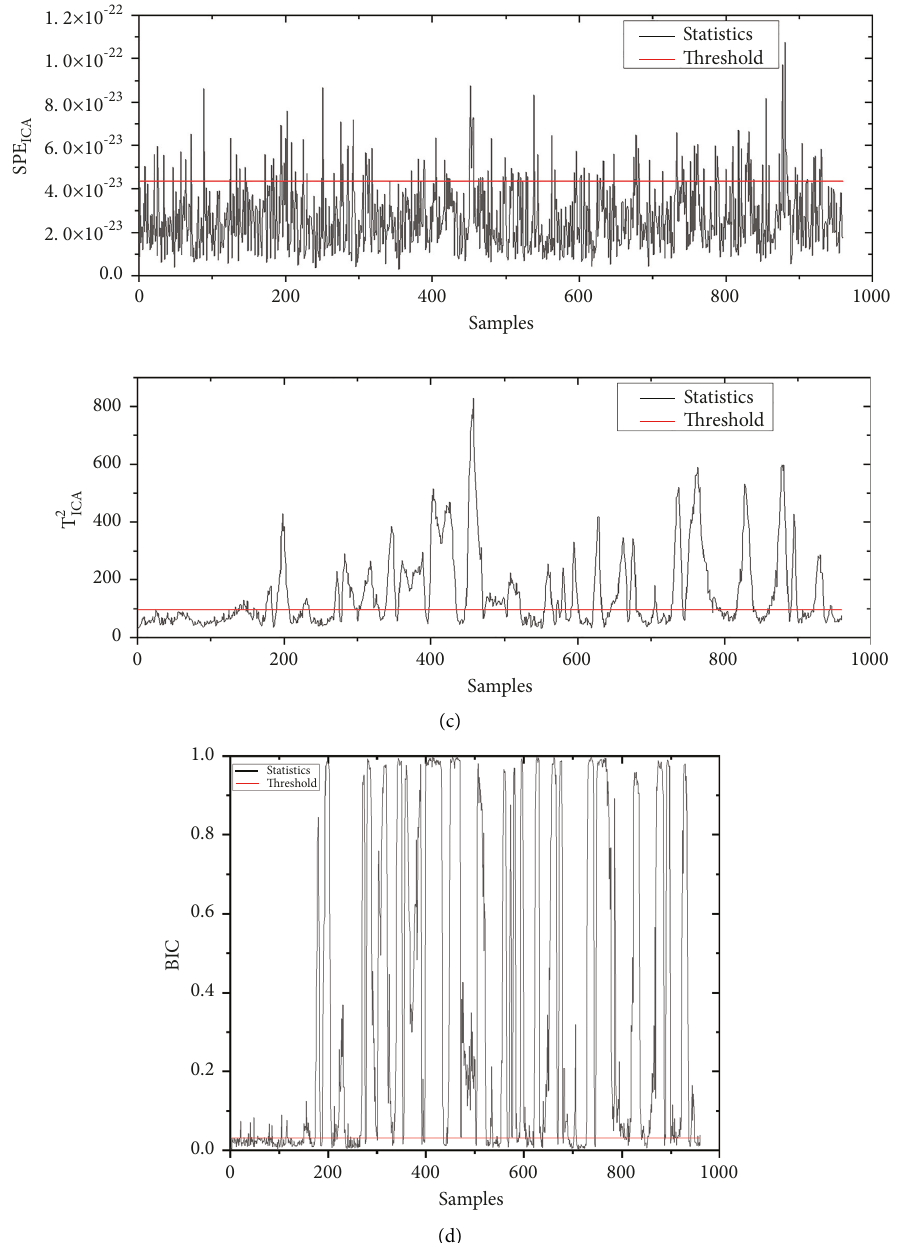
Figure 4: Monitoring results of fault 16 in the TE process: (a) PCA; (b) KPCA; (c) ICA; (d)